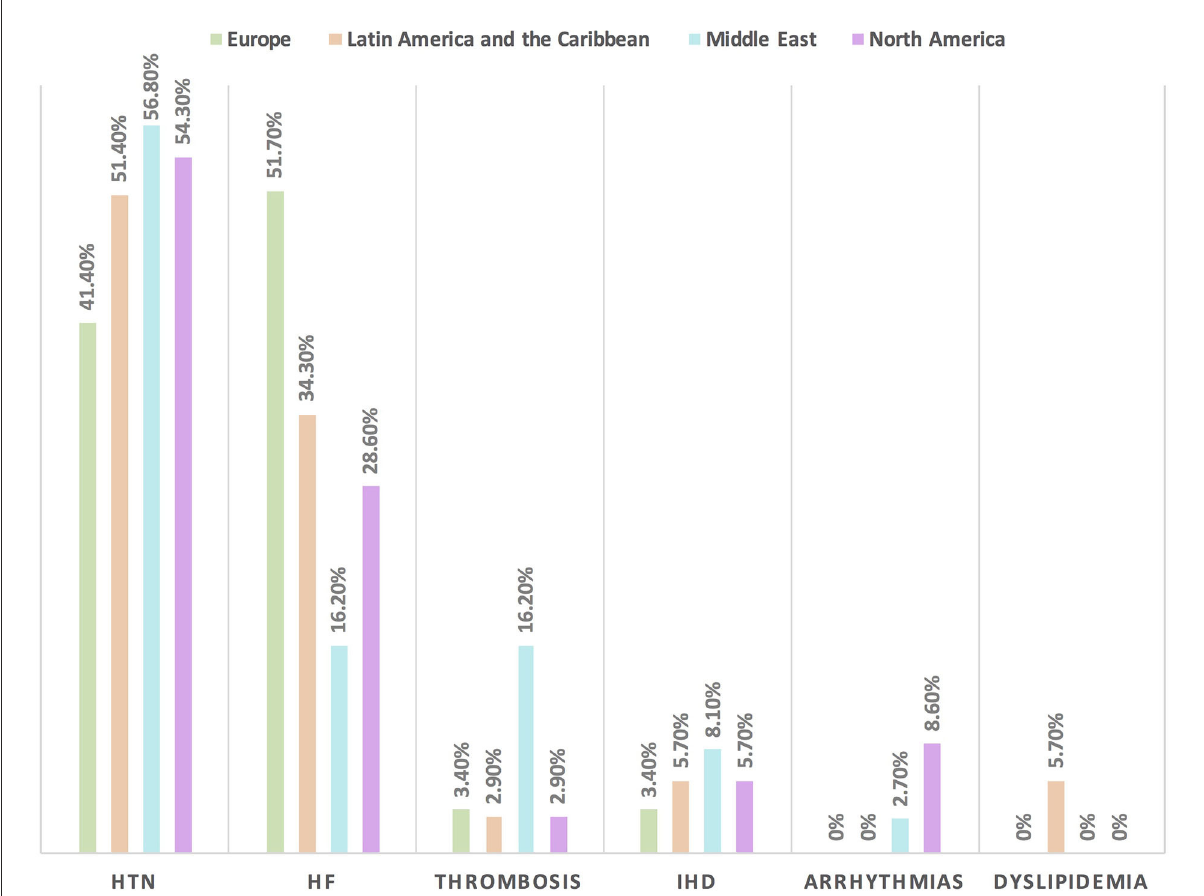
FIGURE3 The most common CVD among patients with cancer in different continents. Hypertension is the main baseline CVD among patients with cancer in all regions except in Europe where heart failure is the most common one. HF, heart failure; HTN, hypertension; IHD, ischemic heart